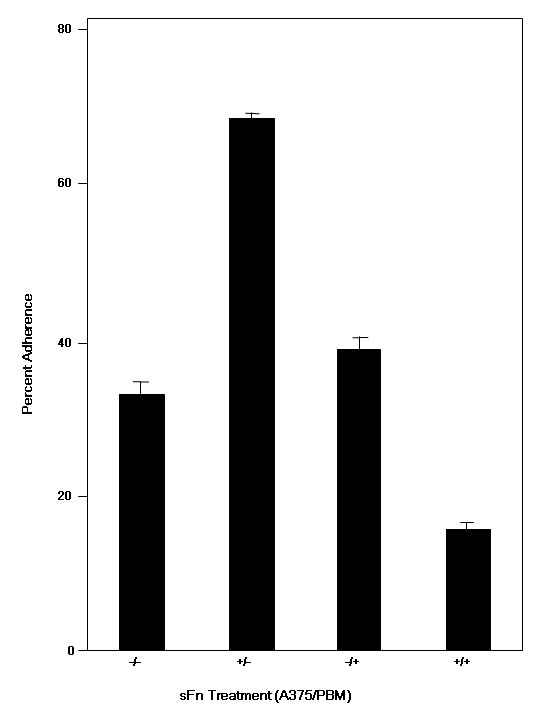
Effect of soluble fibrin on monocyte adherence to tumor cells. Calcein AM labeled PBM incubated with A375 cells after pre-treatment of A375 and/or PBM with RPMI or sFn prior to assay. sFn pre-treatment of tumor cells significantly increased adherence to untreated A375 cells compared to the untreated control (P < 0.01: n = 3). Preincubation of monocytes also marginally increased adherence to untreated A375 cells (P < 0.05: n = 3) compared to the untreated control, but to a significantly lower degree than with sFn treated A375 cells (P < 0.01 compared to monocyte sFn). sFn pre-treatment of both effector and target cells resulted in a significant inhibition of adherence (P < 0.05: n = 3) compared to the untreated control.